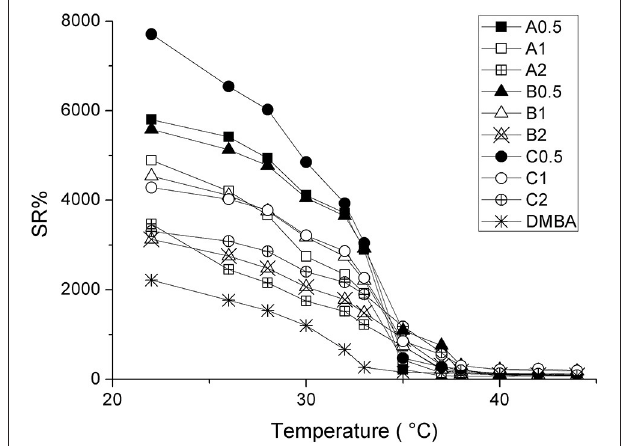
FIGURE 3 | SR% as a function of temperature for synthesized samples, where squares, triangles and circles refer to A, B and C series, respectively. Amount of A γ CD: 0.5 mol% (solid); 1.0 mol% (empty marker); 2.0 mol%